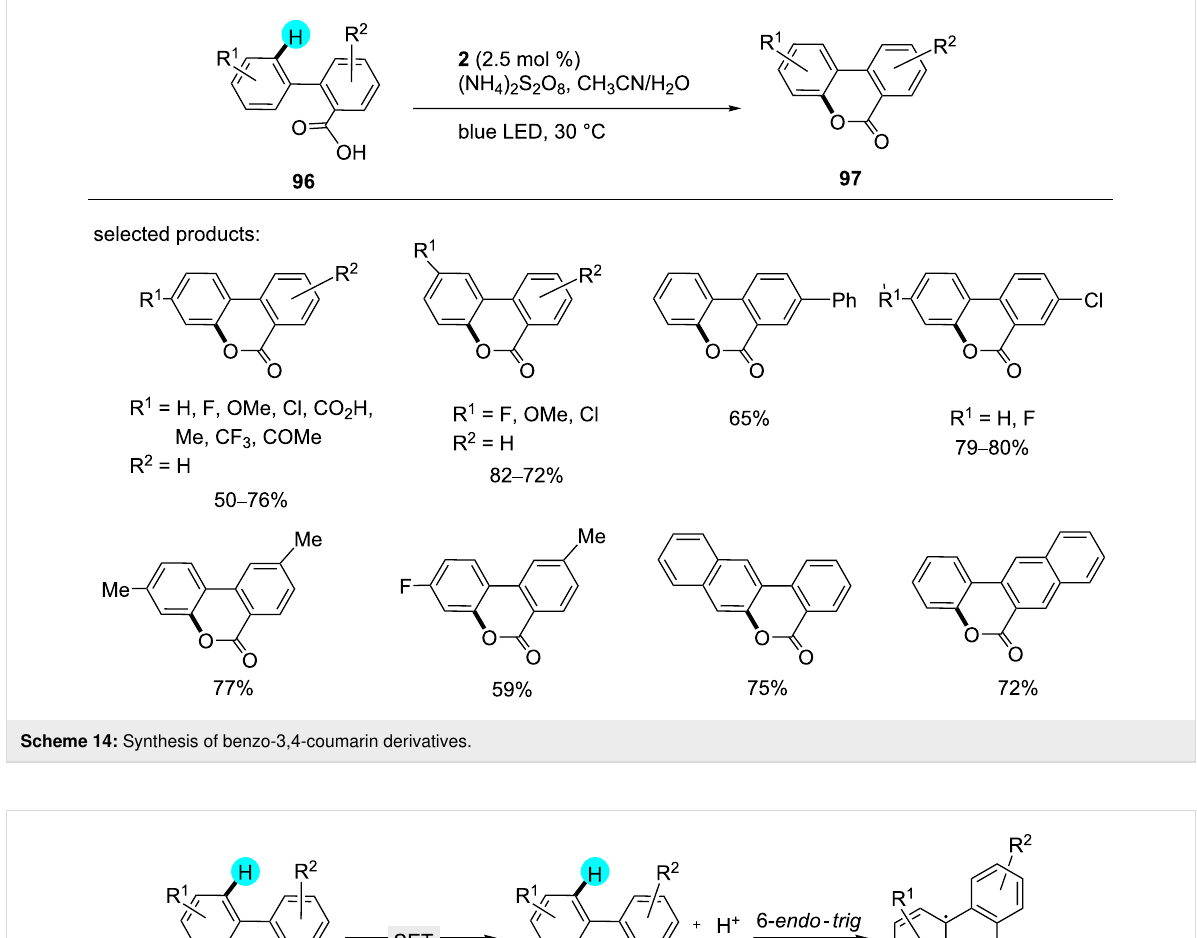
Scheme 14: Synthesis of benzo-3,4-coumarin derivatives.